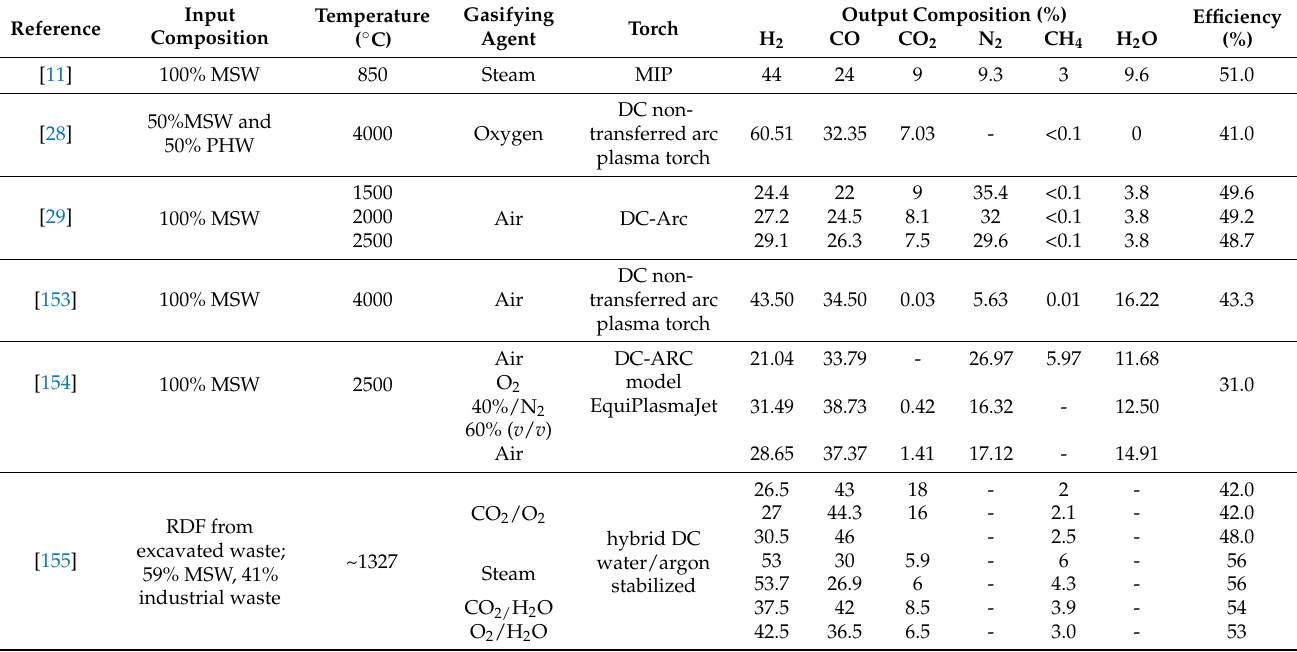
Table 4. Summary of main plasma modeling